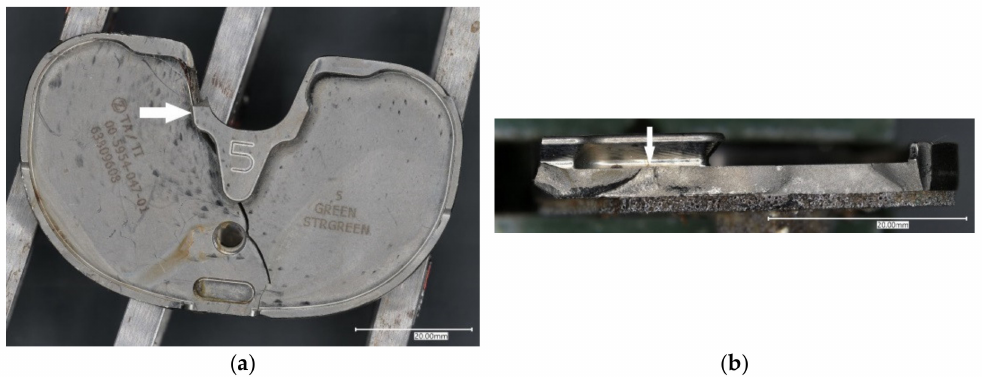
Figure 6. Microphotographs depicting signs of a fatigue fracture of the tibial tray with fatigue crack initiation site (arrows) viewed from above ( a ) and from the fracture side ( b